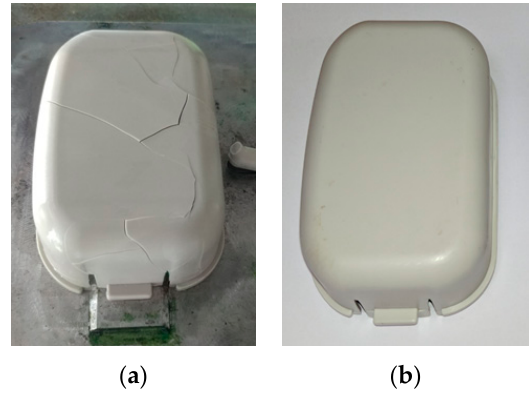
Figure 2. Injection results of (a) PBT (60) and (b) PA6 (60).